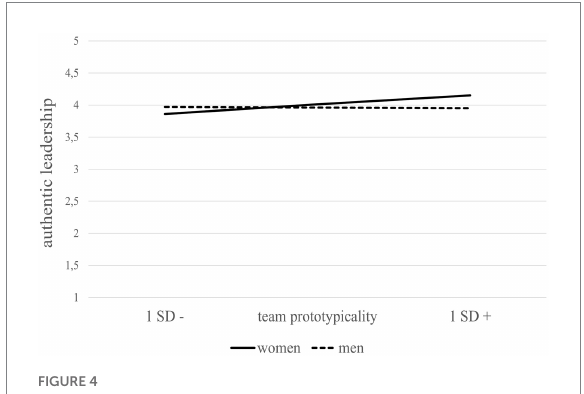
FIGURE 4 Study 1—Interactive effects between participants’ biological sex and team prototypicality manipulation (high vs. low) on authentic leadership.